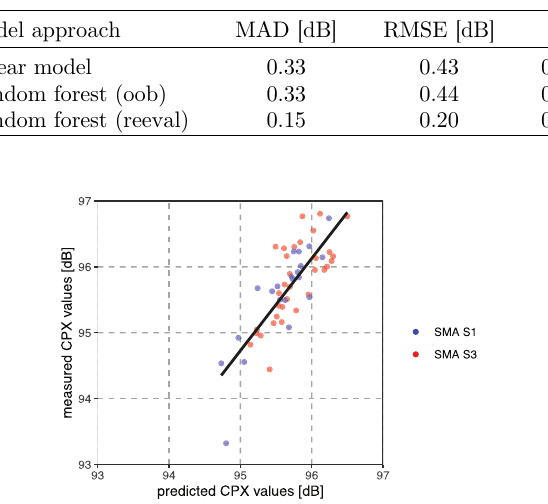
Figure 15. Reevaluation of the combined overall linear prin- cipal component CPX model. The black line shows the linear regression model of the prediction.